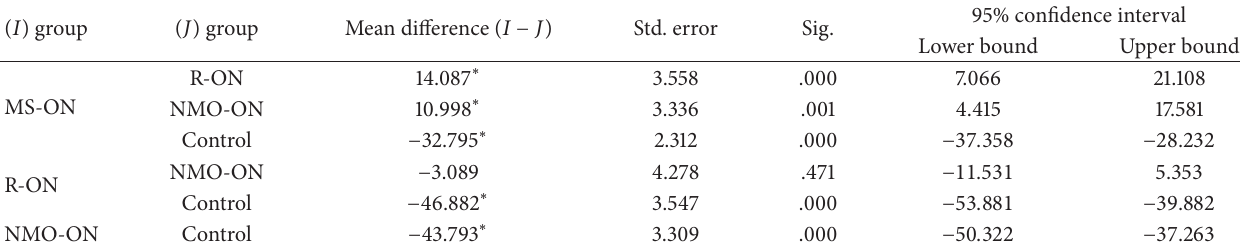
Table 3: Repeated measures ANOVA of multiple comparisons of each